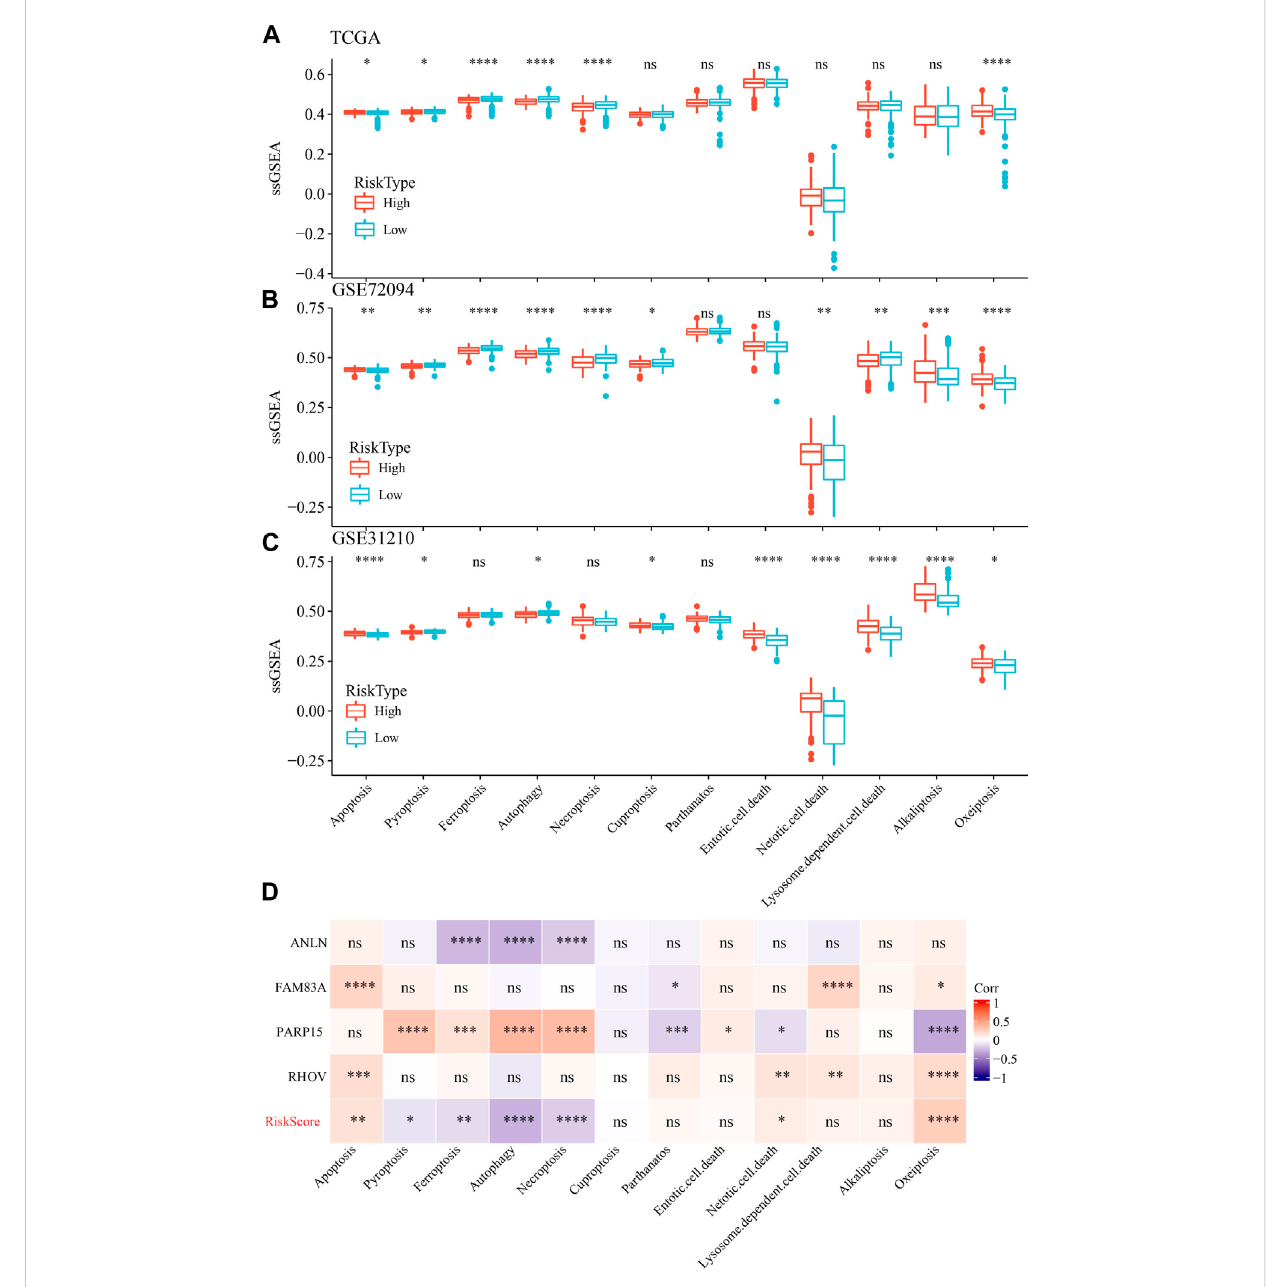
FIGURE 11 The ssGSEA analysis of 12 PCD patterns in high- and low-groups. (A) ssGSEA analysis of 12 PCD in high- and low-group in TCGA-LUAD dataset. (B) ssGSEA analysis of 12 PCD in high- and low-group in GSE72094 dataset. (C) ssGSEA analysis of 12 PCD in high- and low-group in GSE31210 dataset. (D) the association among RiskScore, model genes and 12 PCD